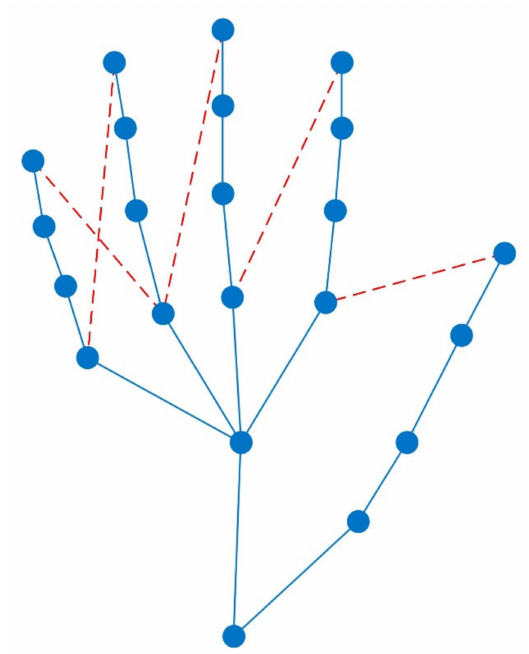
Figure 4. Add non-physical connections to the hand skeleton